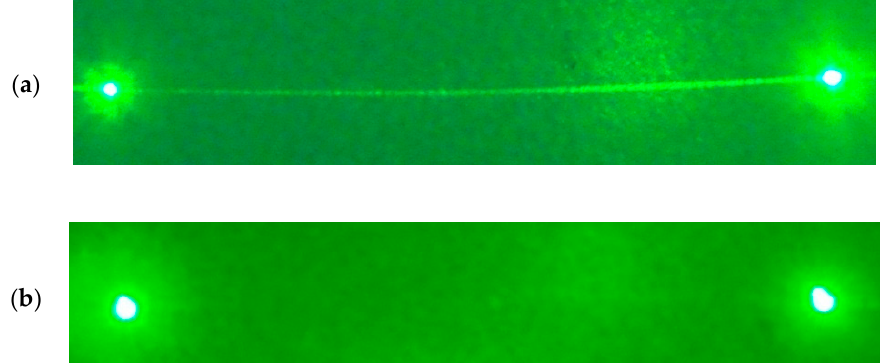
Figure 16. Physical view of stray light measurement of grating: ( a ) without error compensation; ( b ) with error compensation.